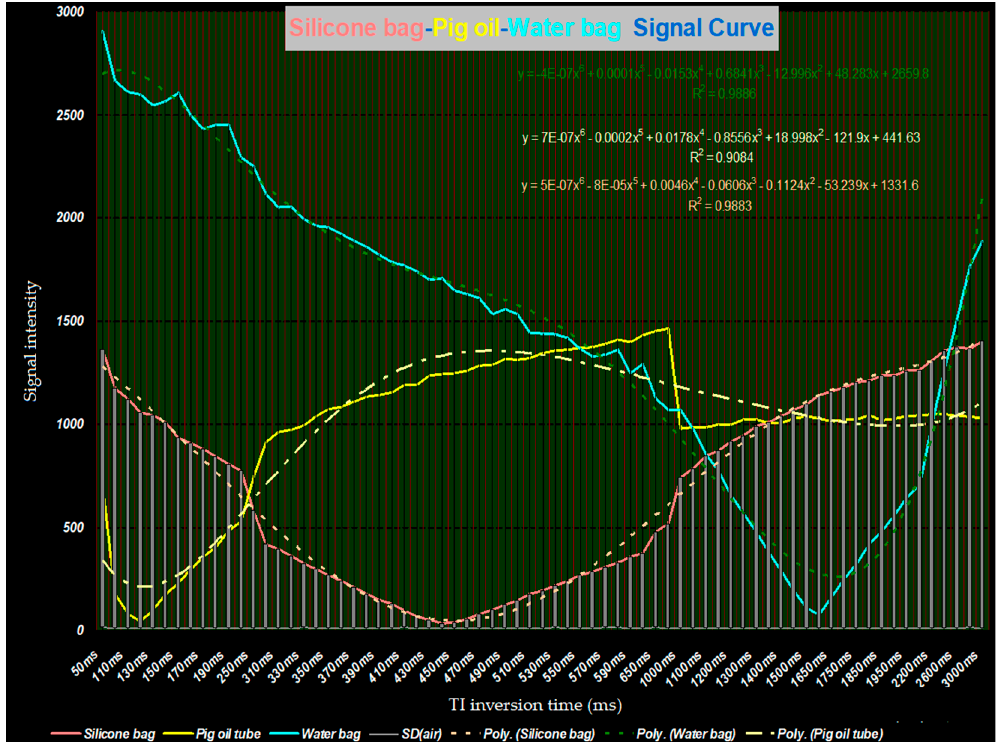
Figure 7. Signal intensity curves of the magnetic resonance images of the three materials (fat, silicone, and saline) with IR. The polynomial smooth curves are shown as dotted lines.